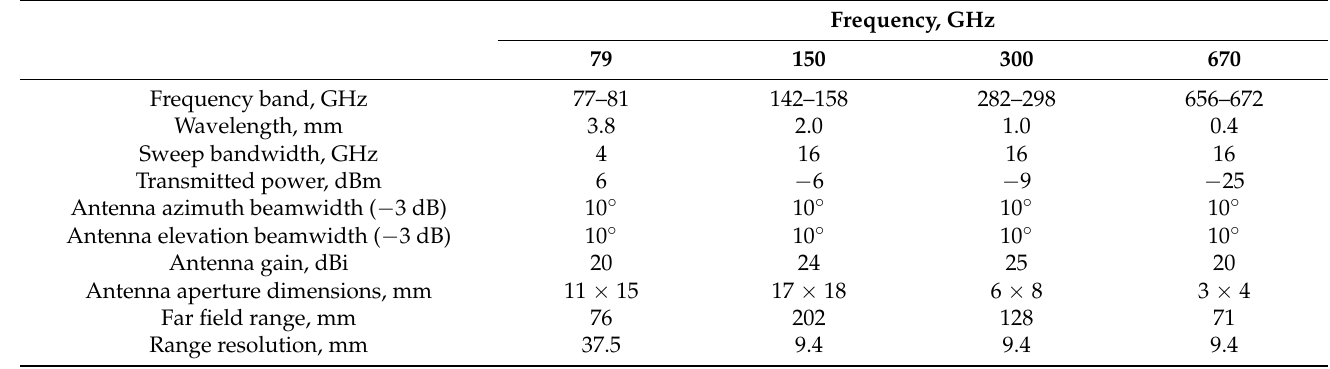
Table 2. Parameters of the measurement